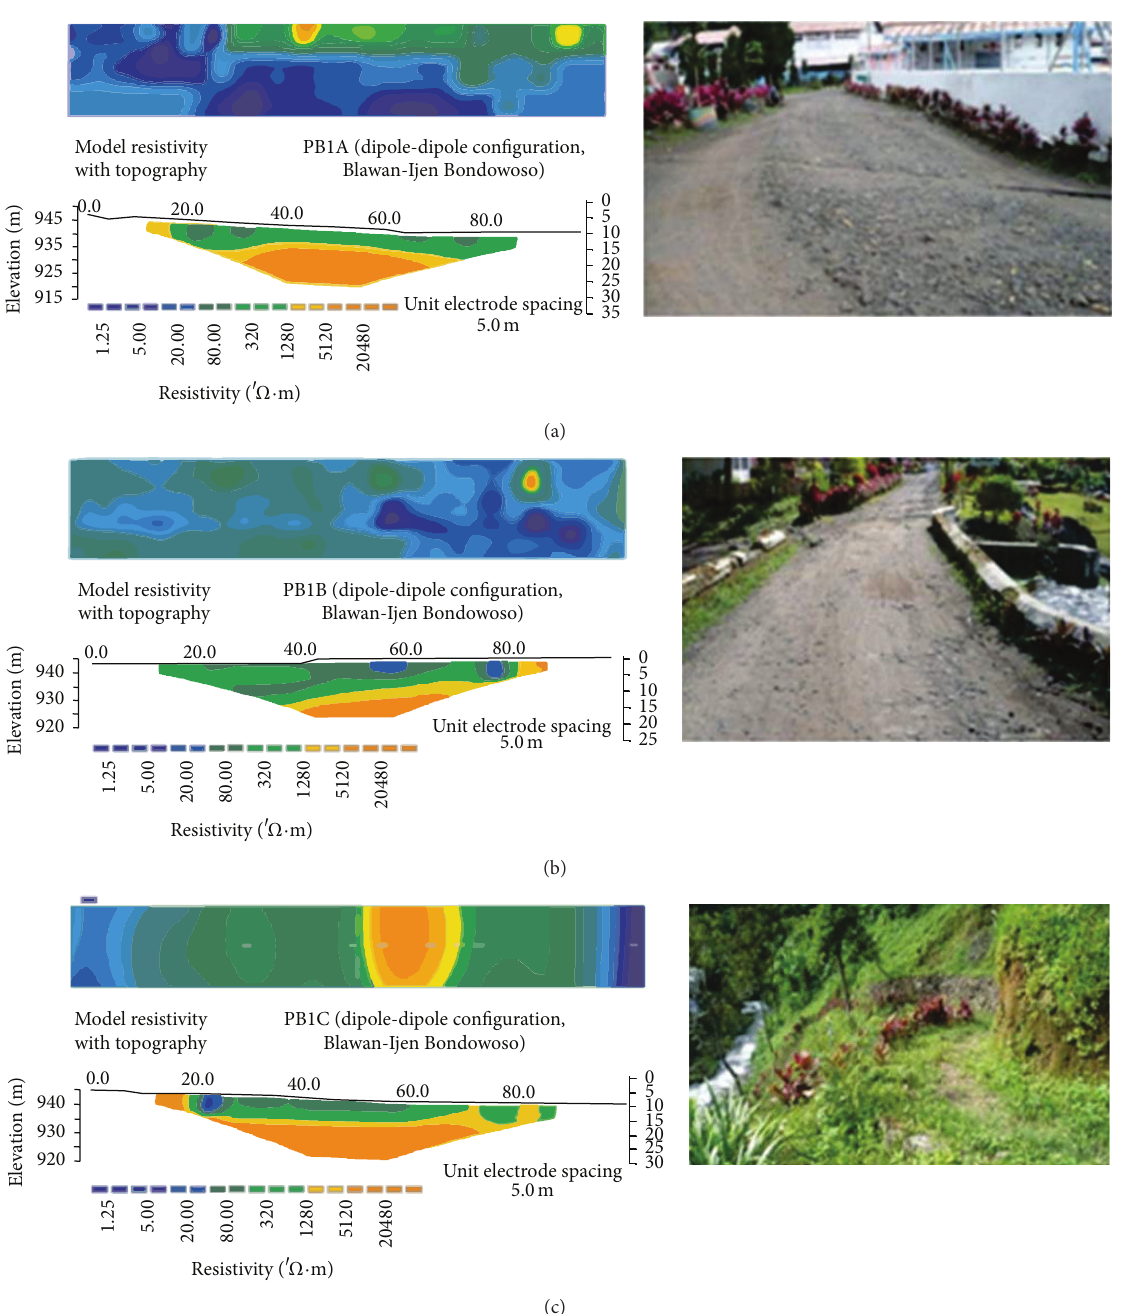
layers that represent the layers of rock containing water. Con- ditions at the site showed that at PB1 there is a river flow in accordance with the GPR results. Yellow to orange layer from GPR processing results is a layer of dry solid and indicated by the presence of